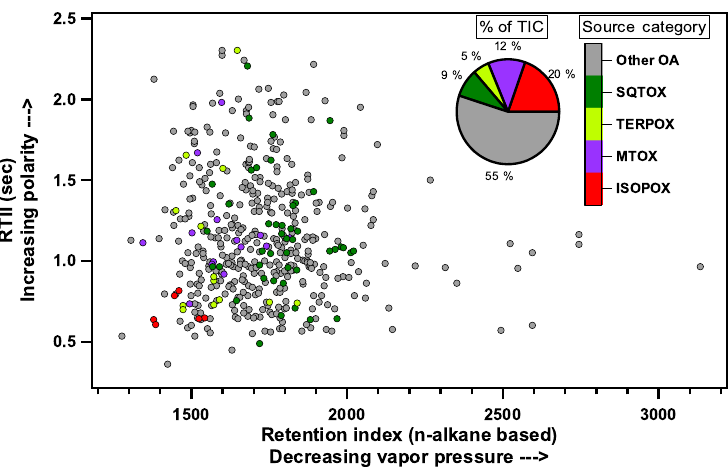
Figure 9. GC × GC chromatogram of nighttime filter sample during the wet season. Peaks are assigned source categories of isoprene oxi- dation products (ISOPOXs) in red, monoterpene oxidation products (MTOXs) in purple, terpene oxidation products (TERPOXs) in yellow, and sesquiterpene oxidation products (SQTOXs) in green. Other unidentified OA in grey. The percentage of total ion chromatogram is made up by each source category shown in the pie